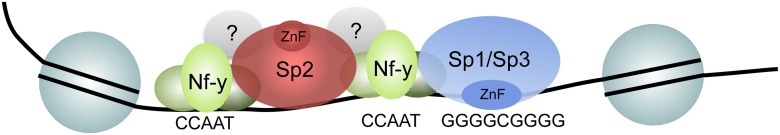
Model depicting the recruitment of Sp1/Sp3 and Sp2 to their target promoters in vivo.Consistent with in vitro binding data, Sp1 and Sp3 are recruited to GC boxes by their zinc finger domain. The majority of Sp2 is recruited to CCAAT motifs (often arranged in tandem) that are co-bound by Nf-y. Binding of Sp2 to these sites is by its N-terminal region, and is independent of the zinc finger domain. The strength of binding to these sites and the presence of positively charged amino acids in the N-terminal region of Sp2 might indicate that protein-protein as well as unspecific protein-DNA interactions are involved.